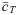
Structure of the nullclines at different values of c¯T indicated in the title of each panel.The black line indicates the nullcline P˙o=0, while the orange line corresponds to c˙sr=0. The red curve is a trajectory with a direction indicated with the red arrows.